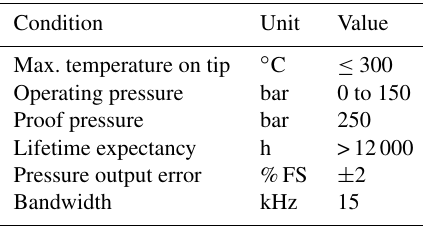
Table 1. Typical requirements for cylinder pressure measurements (Sensata,